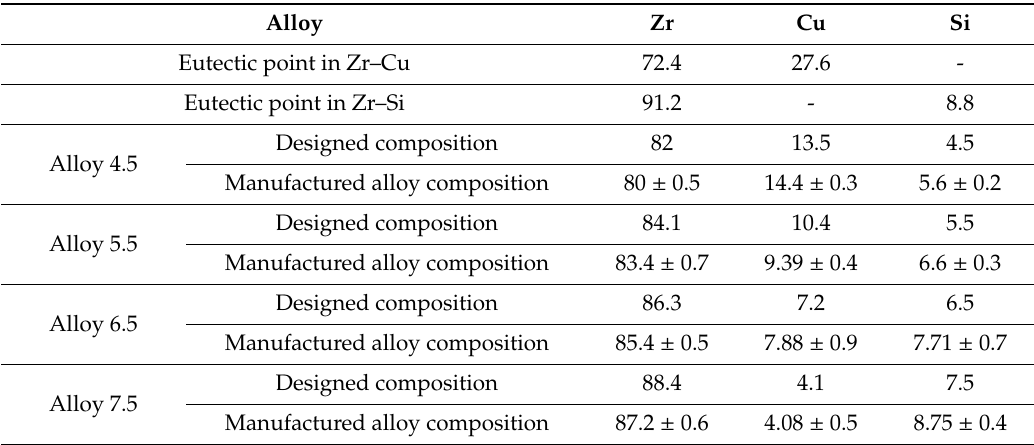
Table 1. Compositions of designed alloys fabricated by arc melting (at.%) a